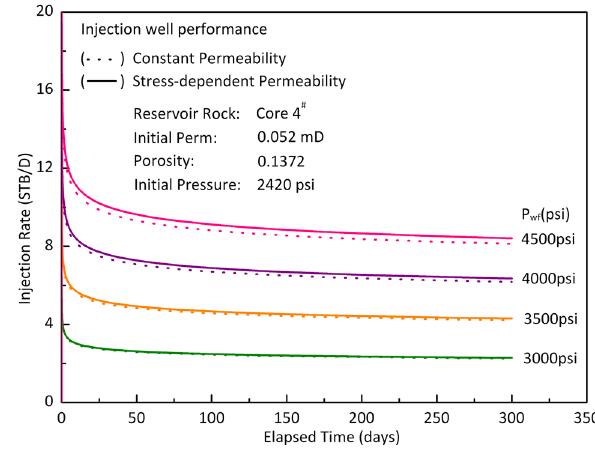
Fig. 6 Permeability distributions on day 300 under different produc- ing pressures Fig. 7 Injection rates under different injection pressures